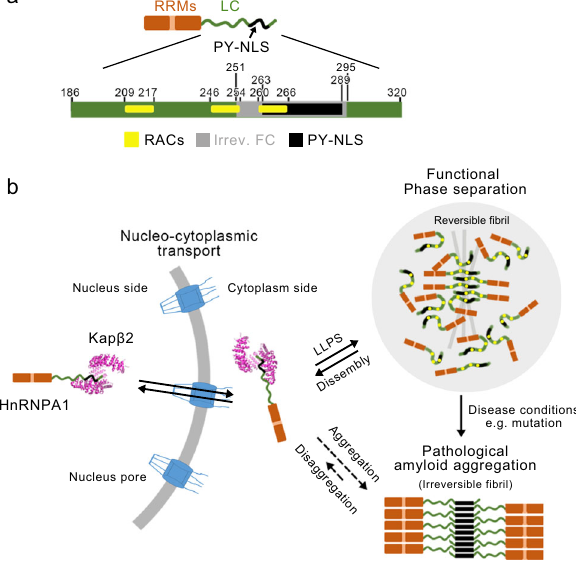
Fig. 5 Hypothesis of hnRNPA1 forming different structures to adapt to different function. a Domain organization of hnRNPA1. The LC domain is colored in green and zoomed in. Segment 251 – 295 that is involved in the the irreversible fi bril core (FC) is colored in gray. The PY-NLS (segment 263 – 289) is highlighted in black. The reversible amyloid-forming core segments (RACs) are highlighted in yellow. b Schematic illustration of the different structural states of hnRNPA1. HnRNPA1 monomer forms complex with Kap β 2 via PY-NLS. In the state of phase separation, the LC domain play a major role in mediating self-association of hnRNPA1 for liquid – liquid phase separation (LLPS) and reversible amyloid fi bril formation.